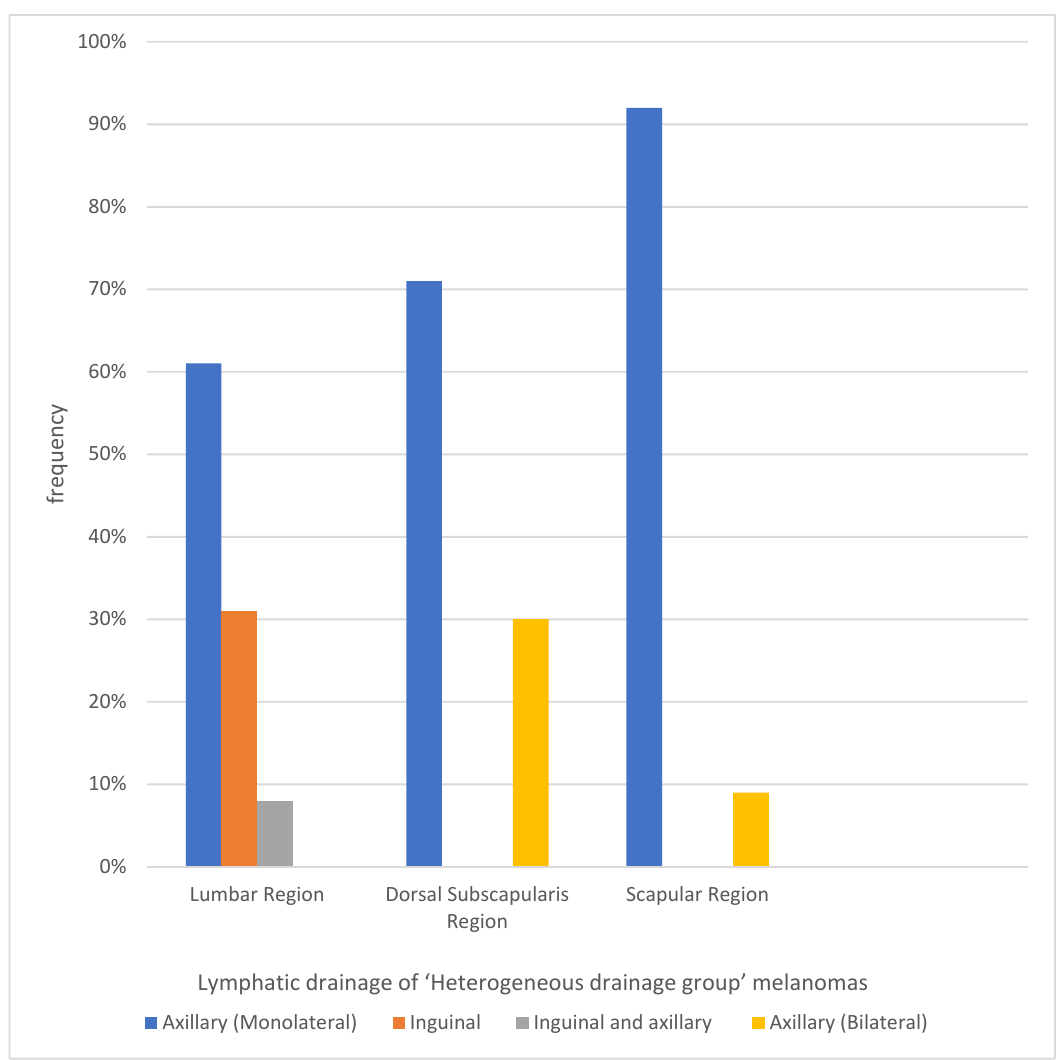
Figure 4. Lymphatic drainage of “Heterogeneous drainage group” melanomas. 2. Dorsal subscapularis region . Seventeen cutaneous melanomas were localized to this re ‐ gion (10.3% of all included patients) (Figure 1). The skin melanoma drained into the homolateral (70.59%) or bilateral (29.41%) axillary lymph nodes (Figure 4). The pT evaluation reported three pT1b, four pT2a, two pT2b, two pT3a, three pT3b, and two pT4a cases; in one case the pT evaluation was not reported (Table 3). 3. Scapular region . Thirty ‐ five cutaneous melanomas were located in this region (21.21% of all included patients) (Figure 1). Drainage of the skin melanoma was to the homo ‐ lateral axillary region in 91.43% of the cases; bilateral drainage was reported in only three cases (8.57%) (Figure 4). The pT evaluation reported eight pT1b, nine pT2a, one pT2b, three pT3a, four pT3b, two pT4a, and six pT4b cases. In one case the pT evalu ‐ ation was not reported (Table 3). To measure heterogeneity, the Shannon entropy index H has been computed for ei ‐ ther the site or the laterality on these last three groups and differences between H values has been tested through the Hutcheson t ‐ test, by obtaining the following results: Lumbar region has a most significant ( p < 0.01) heterogeneous site of lymph node region drainage with a Shannon index of 0.876 (CI 0.500–1.217) with respect to the 0.347 (CI 0.055–0.639) of the Scapular region (Figure 5).